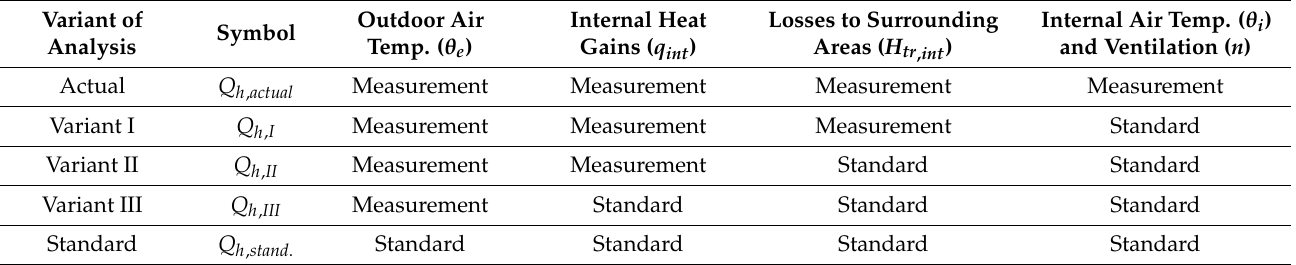
Table 4. Variants for use of dwellings (heating).